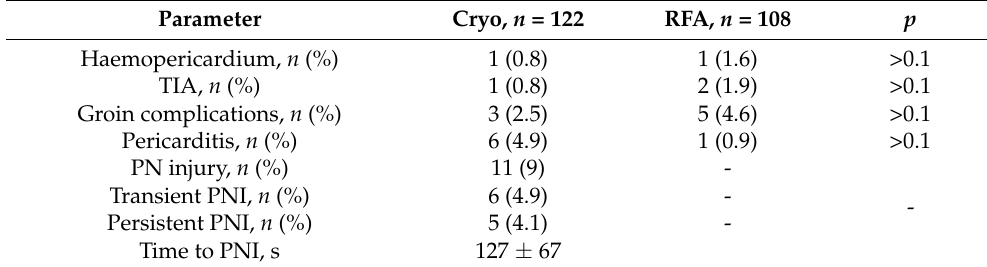
Table 2. Complication’s